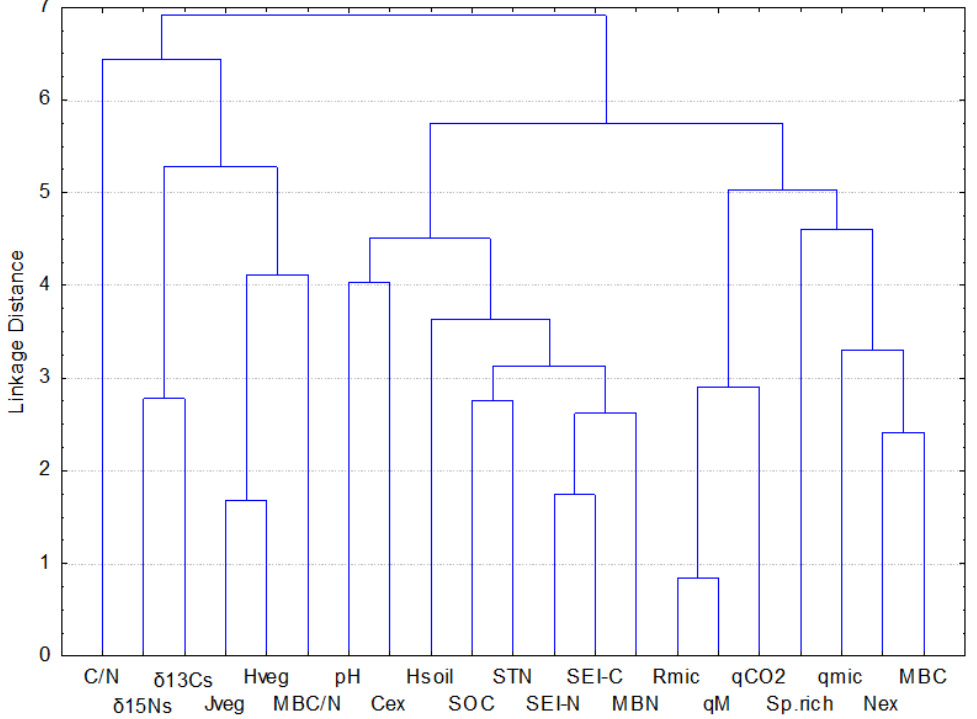
Figure 9. Joining tree clustering analyses of soil and vegetation-related